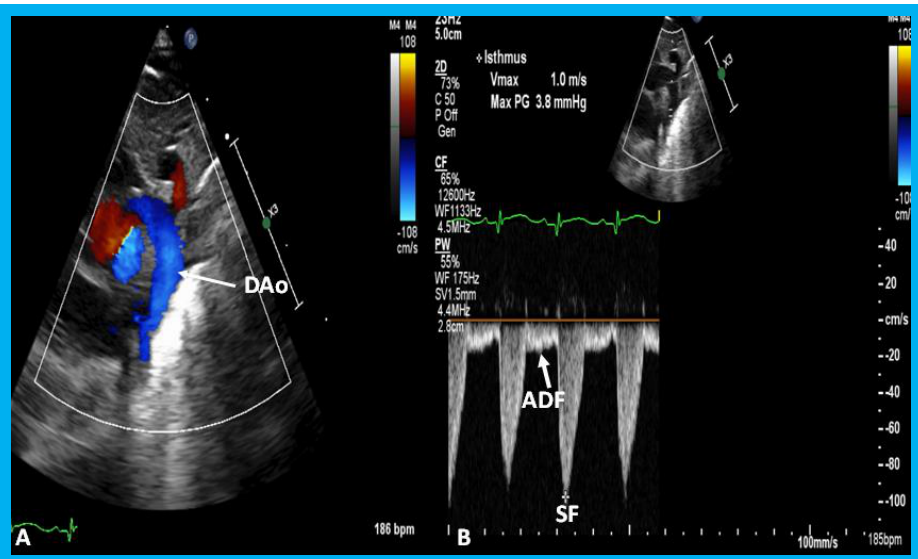
Figure 34. ( A ) Echocardiographic frame from a suprasternal notch view illustrating laminar flow in the descending aorta (DAo) in a premature infant with a small ductus (not shown). ( B ) Continuous wave Doppler recording in the same infant shows normal systolic flow (SF) (*) and normal anterograde diastolic flow (ADF) in the DAo; the diastolic flow is seen below the baseline.